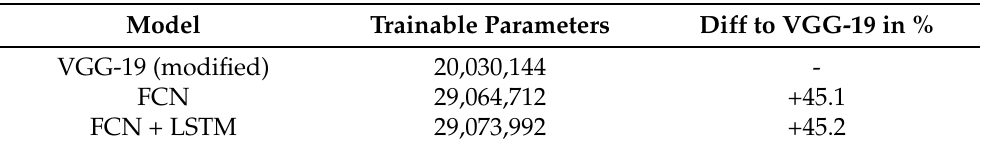
Table 2. Comparison of trainable parameters. The compared models are the VGG-19 as the un- derlying image classification CNN, our FCN consisting of a U-Net with the VGG-19 as its encoder, and our FCN+LSTM model. The parameters for the VGG-19 are given for a modification that uses 13 input channels and has eight output classes. We list the total trainable parameters and the relative difference compared to the VGG-19 model.